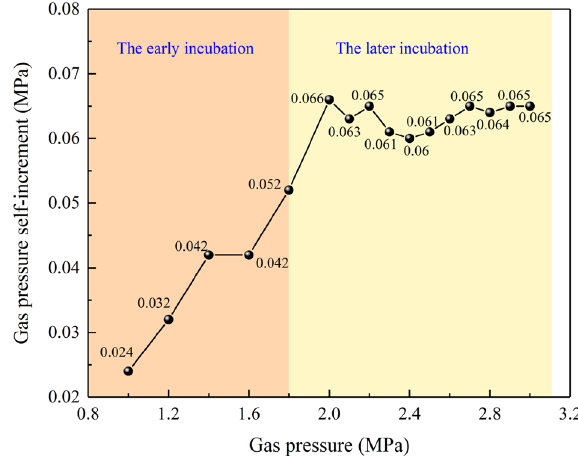
Figure 10. Gas pressure self-increment in each loading stage.